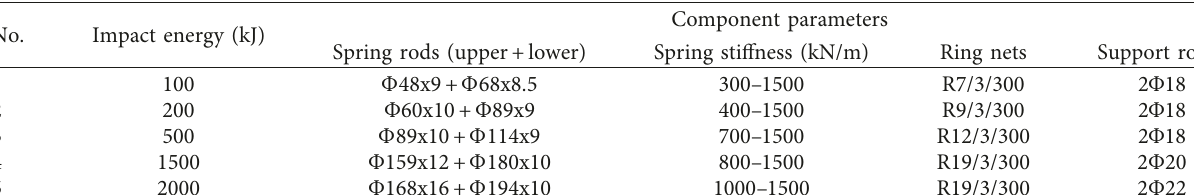
Figure 18: Conversion and dissipation of the impact energy. (a) Conversion of impact energy. (b) Dissipation of impact Table 4: Parameters of the simulation models.